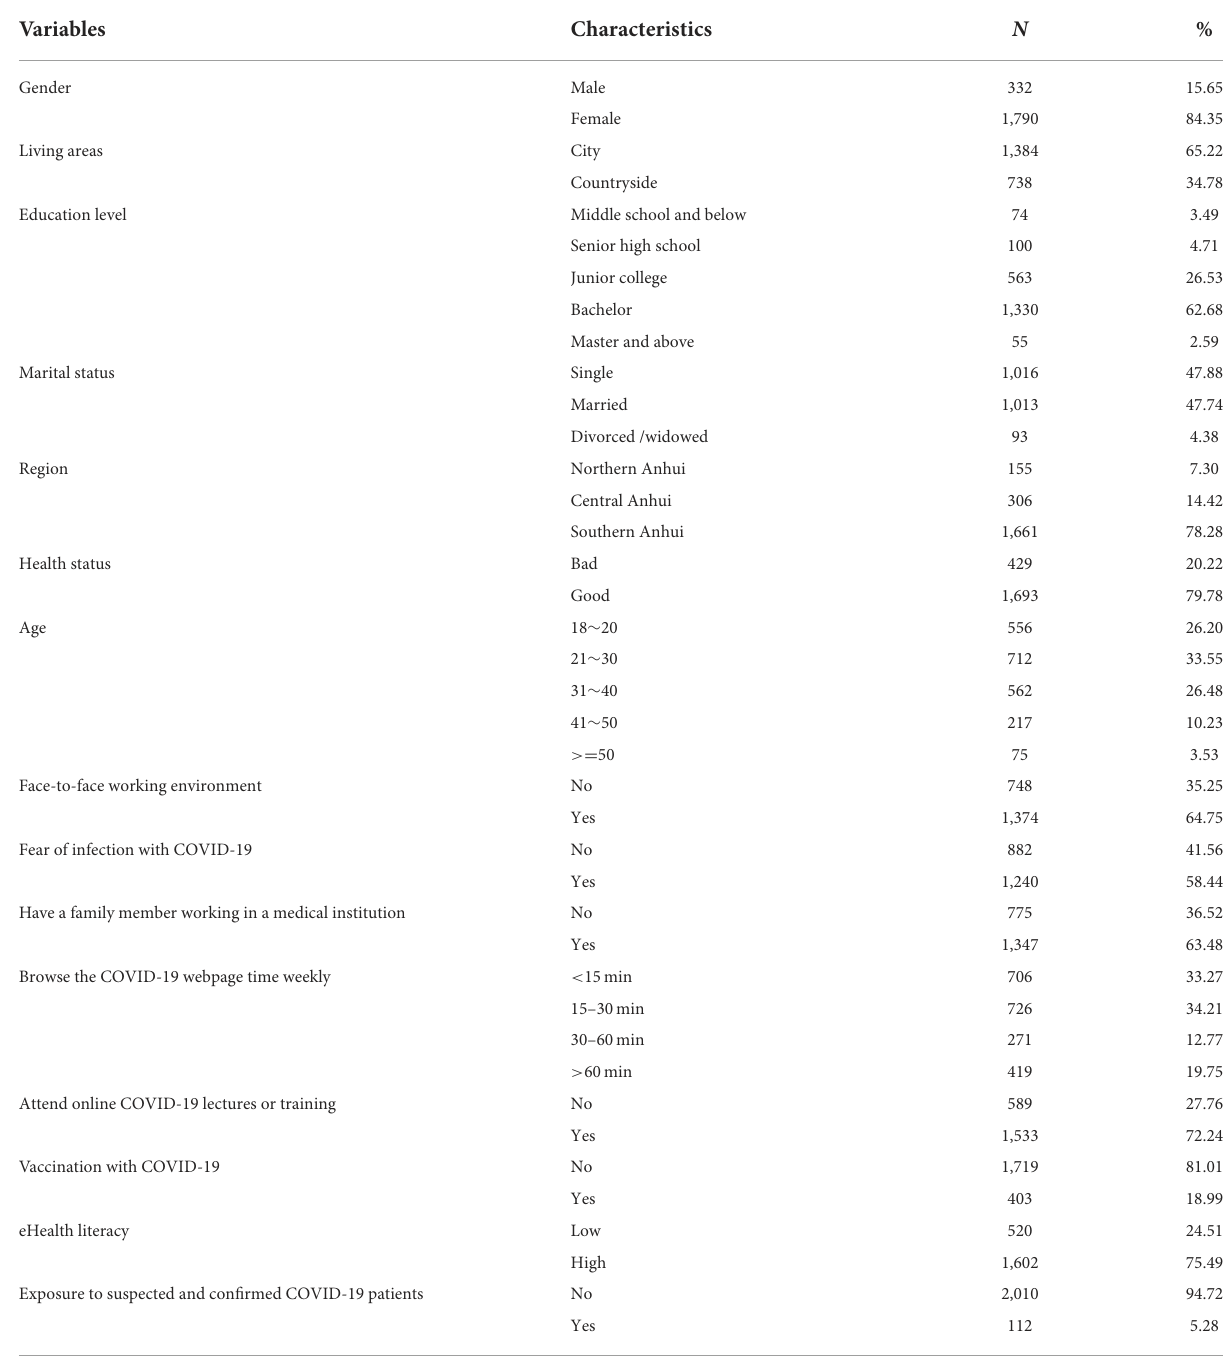
TABLE 1 Sample characteristics ( N =